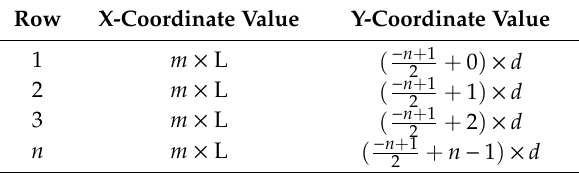
Figure 2. Coordinate system layout for determining the water distribution pattern from a single groove. Table 1. X- and Y-coordinate values for the water depth measurements from a single groove.